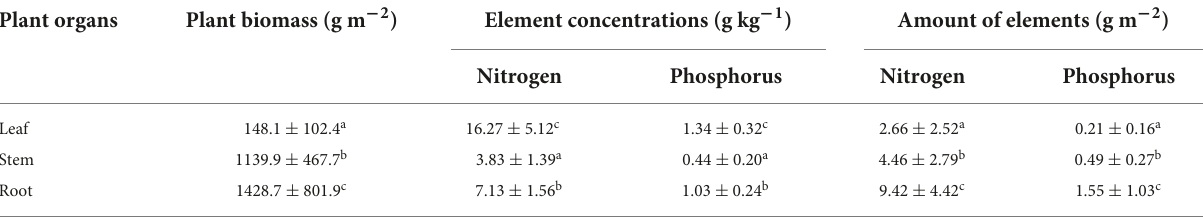
TABLE 1 Plant biomass, concentrations, and amounts of nitrogen and phosphorus (means ± SD) fixed in M. lutarioriparius in the field investigation. Plant organs